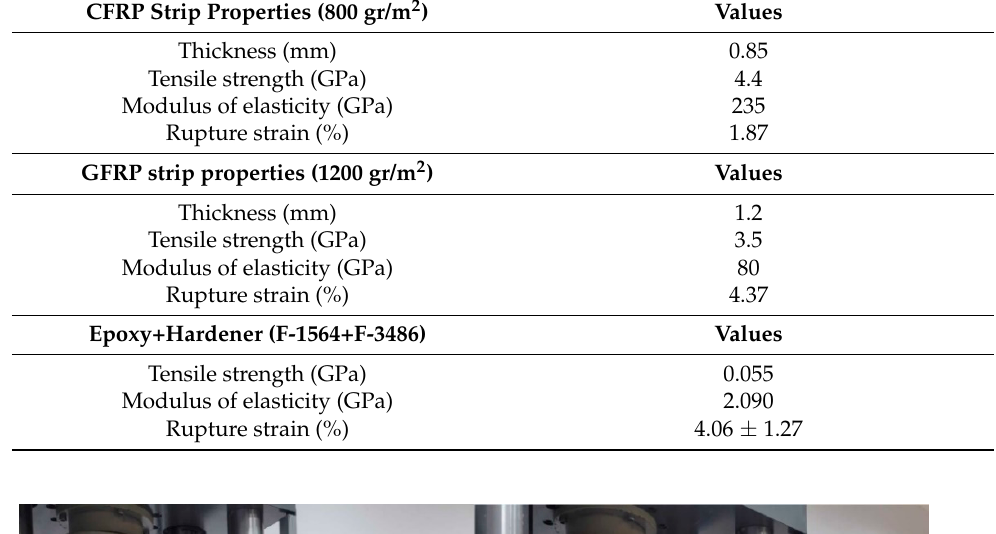
Figure 2. Test setup.